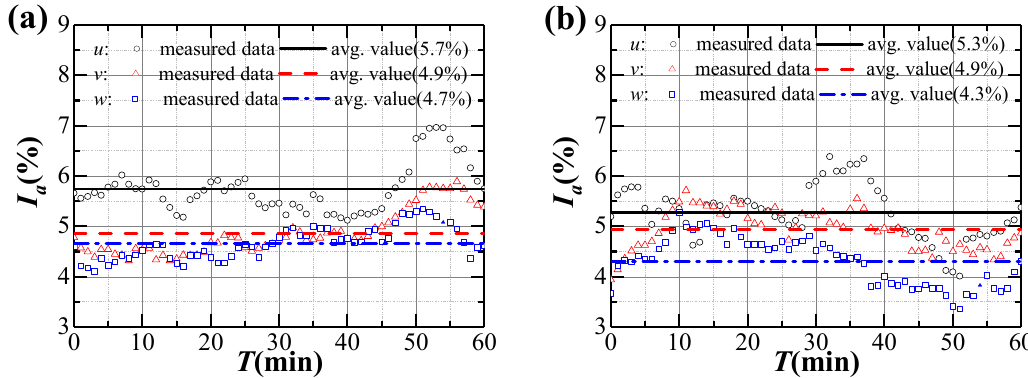
Figure 5. Variation of turbulence intensities during strong winds: ( a ) Typhoon Bailu; ( b ) Strong monsoon event.